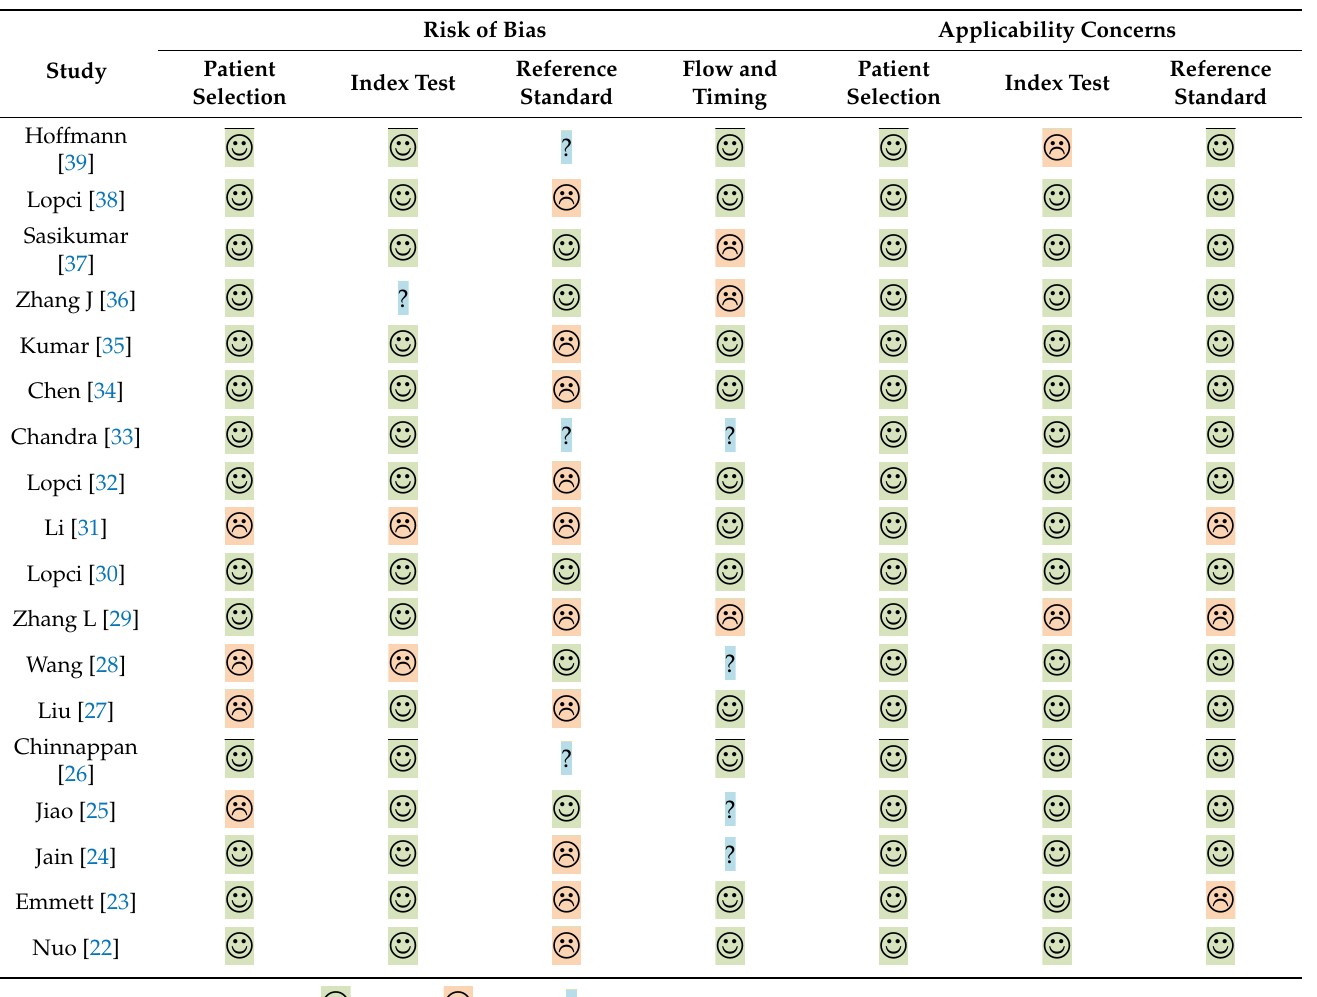
Table 2. QUADAS-2 results showing the assessment for the risk of bias and risk of applicability for the studies that were included in the analysis.